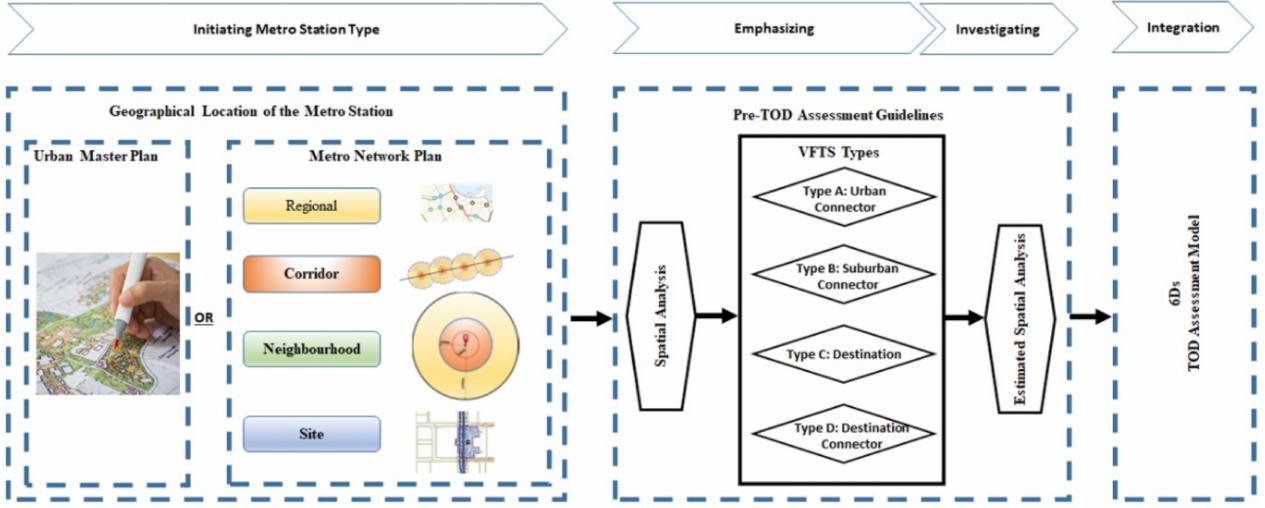
Figure 2. The process of the pre-TOD assessment guidelines versus geographical levels and 6Ds TOD assessment